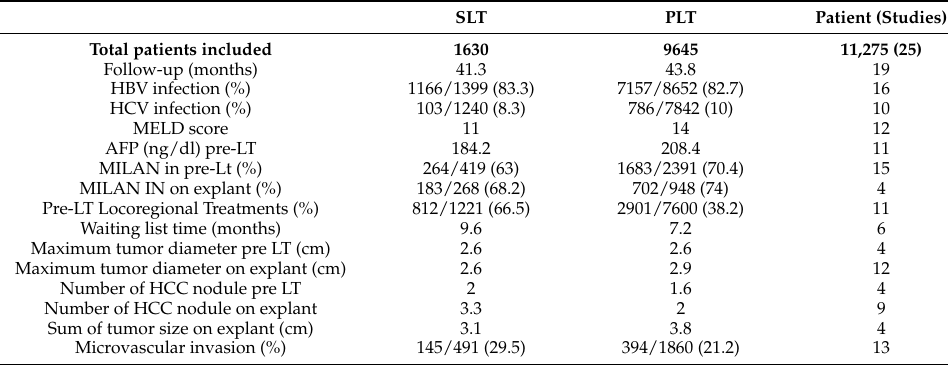
Table 2. General and Patients characteristics.